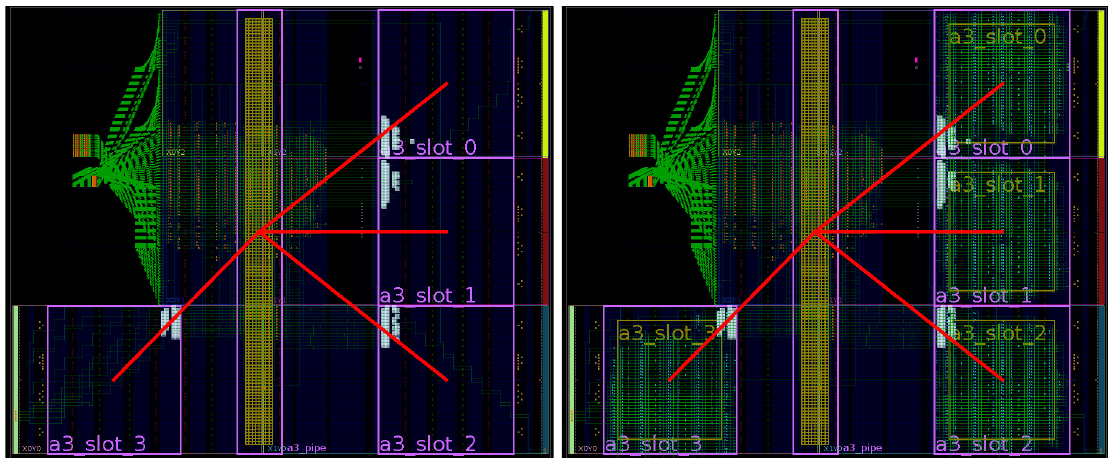
Figure 11. FPGA floorplanning of an ARTICo 3 -based system in a Zynq-based board. Up-to-date design tools (i.e., Vivado) are used for this